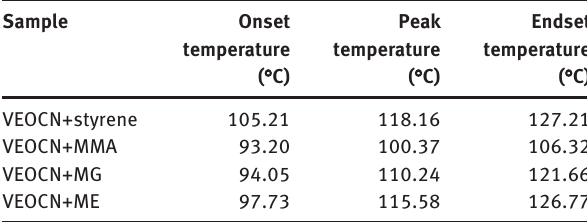
Table 2: The DSC results of the VEOCN samples cured using styrene, MMA, MG and ME as reactive monomers, respectively, during